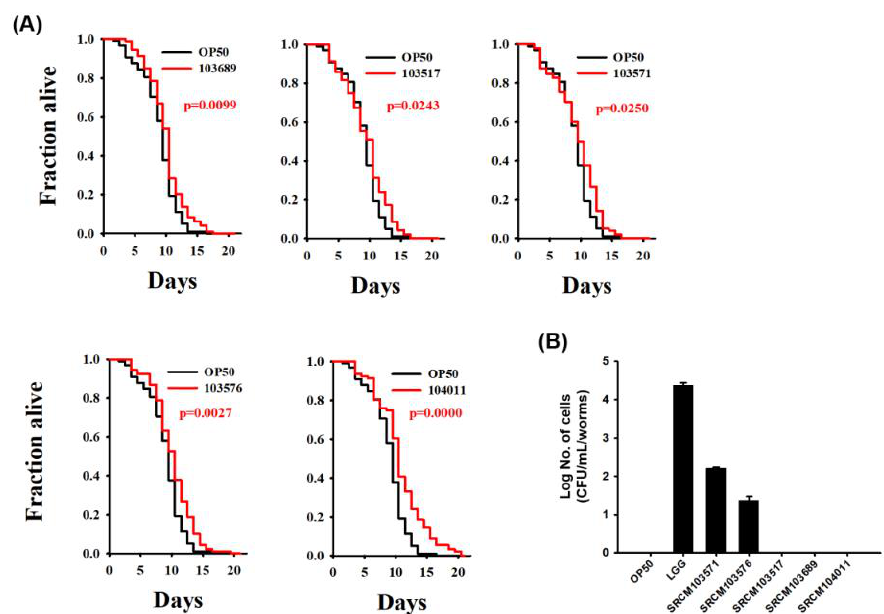
Figure 2. Anti-aging e ff ects ( A ) and persistence ( B ) of selected Bacillus subtilis strains in C. elegans . ( A ) Survival statistics of B. subtilis were compared with the worms exposed to E. coli OP50, with p = 0.0243 for SRCM103517, p = 0.0250 for SRCM103571, p = 0.0027 for SRCM103576, p = 0.0099 for SRCM103689, and p = 0.0000 for SRCM104011, analyzed by Kaplan–Meier analysis. ( B ) After C. elegans was exposed to bacteria for 24 h, the ability of the bacteria to attach to the nematode intestine was confirmed. Data are presented as the mean ± SD of three experiments. The error bars represent the standard deviation.